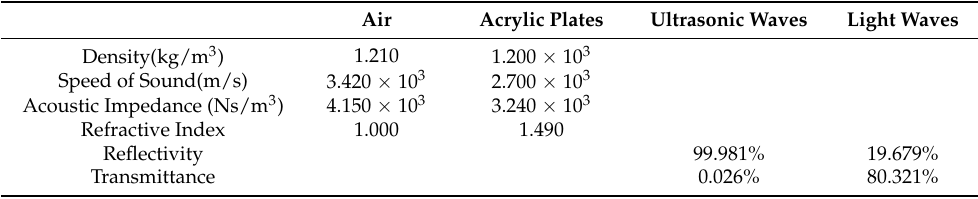
Table 2. Reflectivity and Transmittance of Ultrasonic and Light